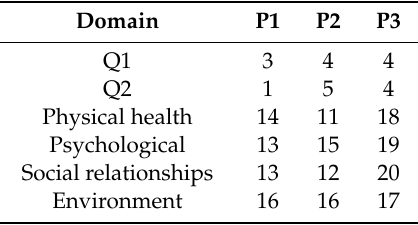
Table 2. WHOQoL (The World Health Organization Quality of Life questionnaire). Q1—Overall perception of the quality of life. Q2—Overall perception of